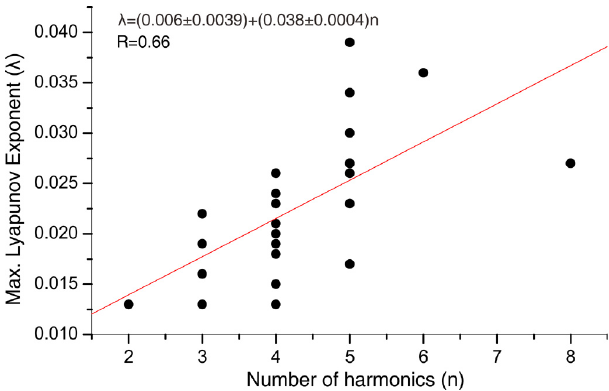
Fig. 8. Diagram showing the relationship between the number of frequency overtones and the values of MLE. The red line indicates the result of the linear regression that was applied to the data. The correlation coefficient R , the slope and intercept along with their error estimates are shown in the upper left hand corner of the